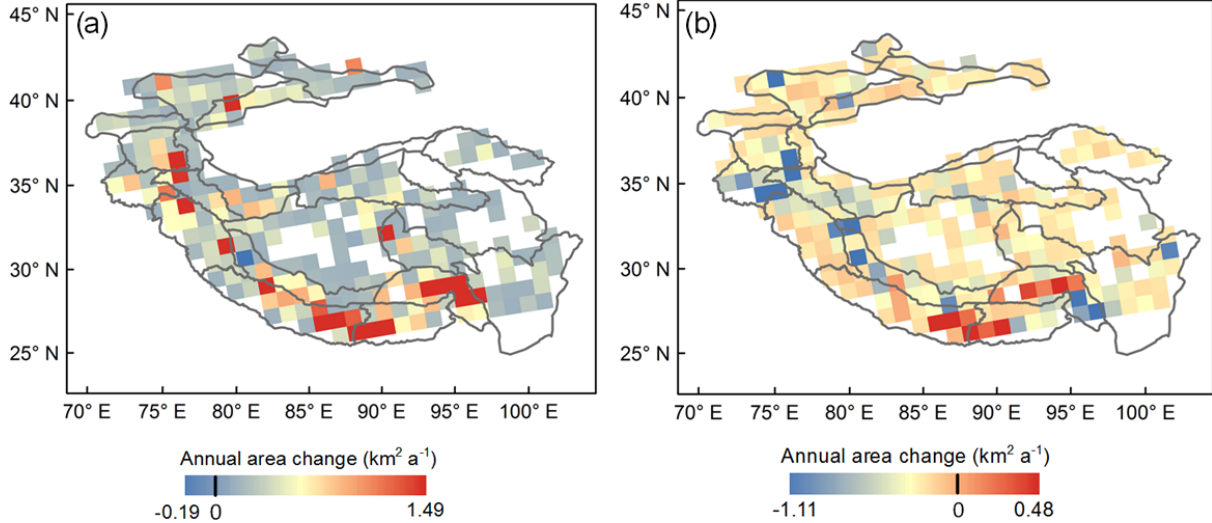
Figure A2. Annual changes in lake area between 2008 and 2017 on a 1 ◦ × 1 ◦ grid. The (a) upper and (b) lower slopes represent the 90% confidence